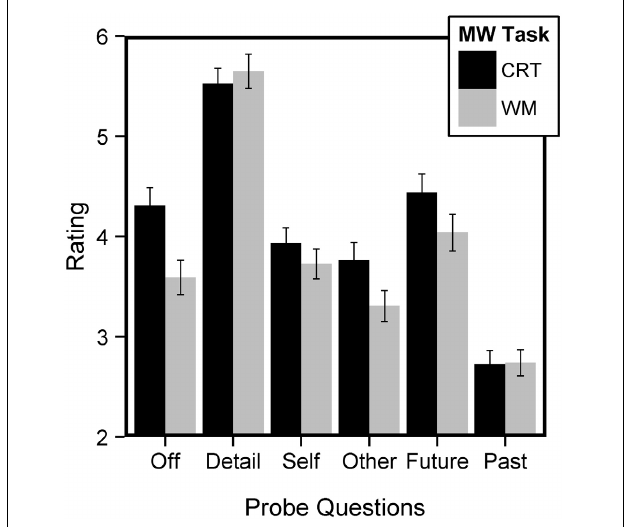
FIGURE 1 | Mean SGT ratings across mind-wandering (MW) tasks. SGT in the CRT task were rated as more Off-task, more Self and Other-related, and more Future-related than SGT in the WM task. In addition, SGT were overall more future than